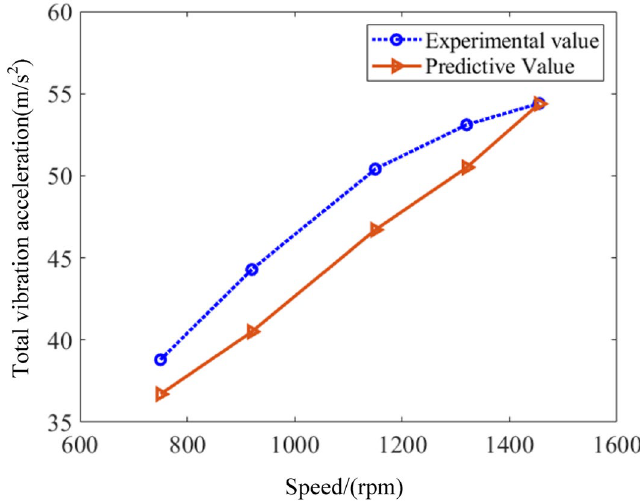
Figure 11. Comparison of vibration between predictive and experimental values.